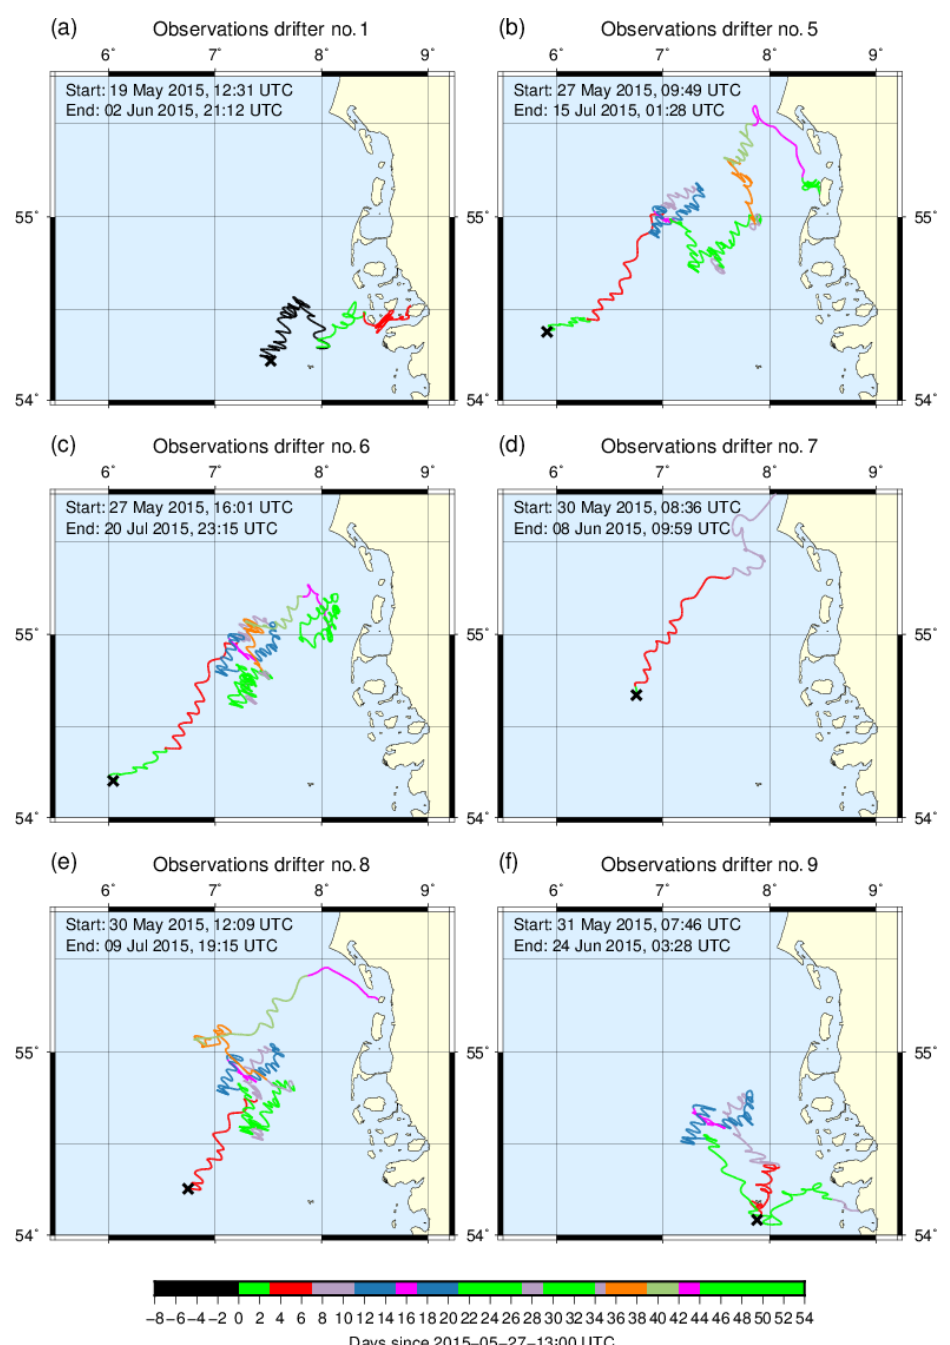
Figure 4. Observed trajectories of six drifters deployed at the locations indicated by black crosses. Drift paths were segmented using the colour code introduced in Table S1. The numerical data underlying this plot can be found in the